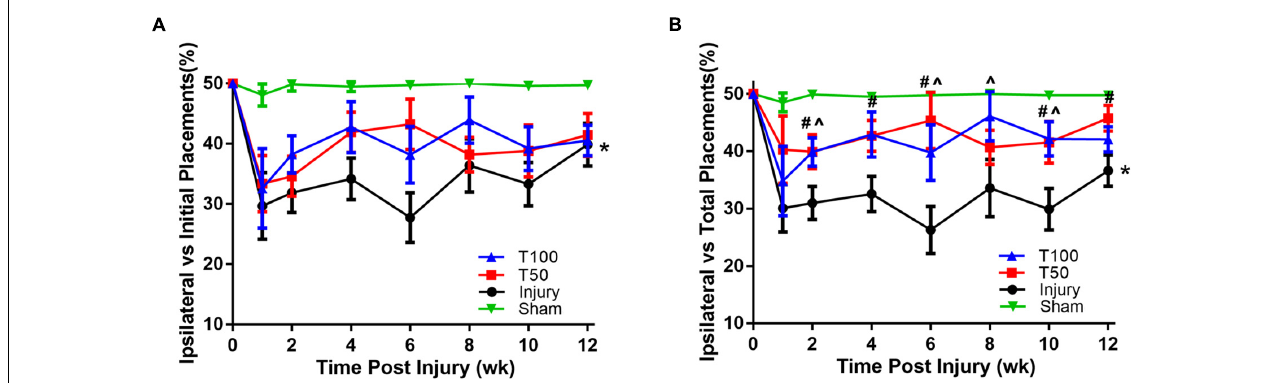
FIGURE 3 | Forelimb asymmetry use task. (A) Frequency of initial placement. (B) Frequency of total placement. * P < 0.05, comparison between each group and the sham group; # P < 0.05, comparison between T50 group and injury group; ∧ P < 0.05, comparison between T100 group and injury group.